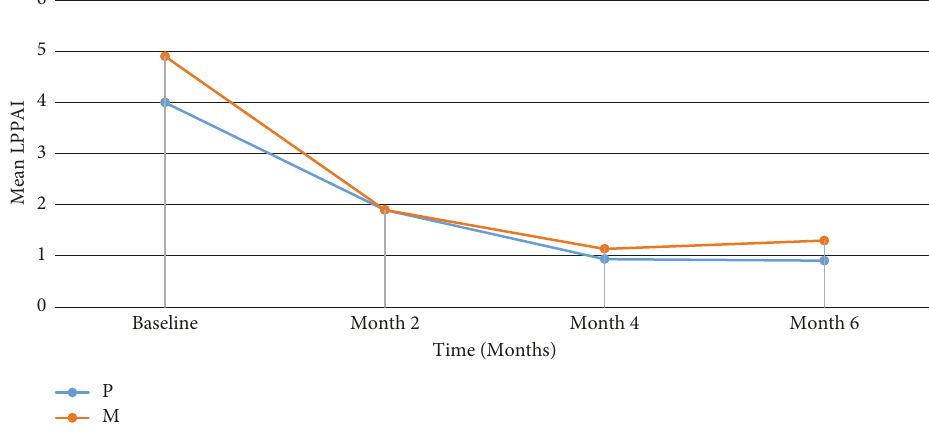
Figure 2: The pattern of decrease in mean Lichen planopilaris activity index in two groups. Table 4: Two-level linear regression model analysis results of Lichen planopilaris activity index. Characteristics